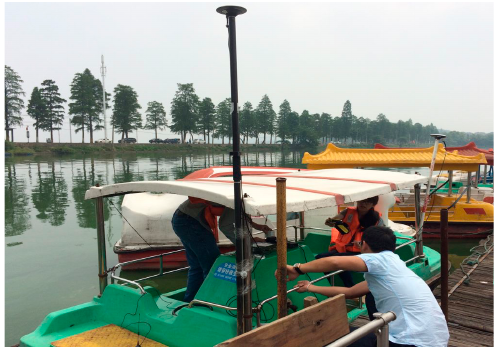
Figure 15. The test environment of shipboard kinematic PPP.